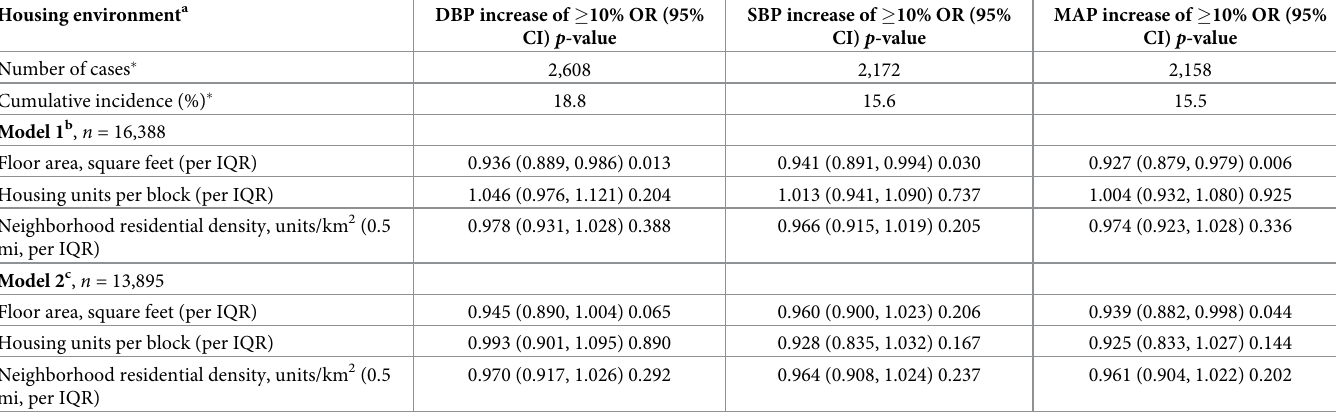
a Model with neighborhood environment (residential density, density of public transport and terrain) measured within 0.5-mile (805m) street catchment of geocoded participants’ residence. b Models adjusting for age at baseline, sex and logarithm of follow-up